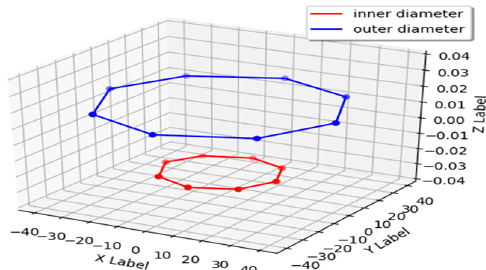
Figure 9. Average values of surface flatness calculated from experimental measurements.